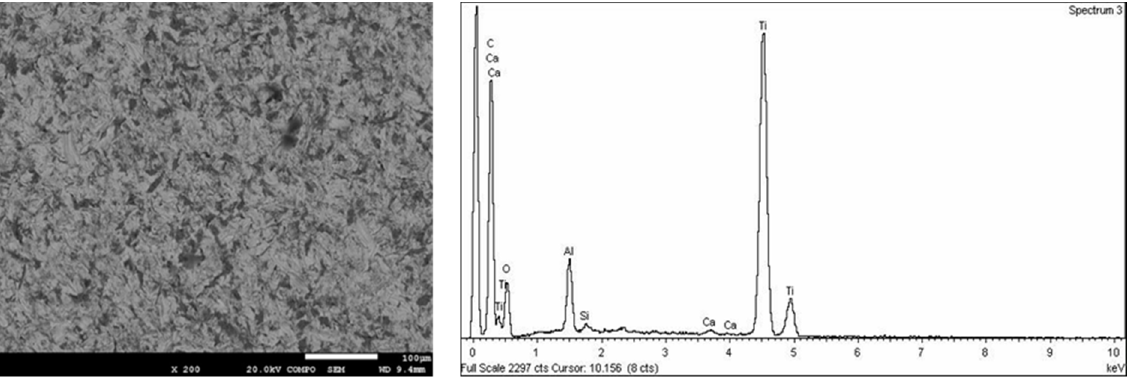
Figure 2. Surface of SB implants observed by scanning electron microscopy and X-ray microanalysis.